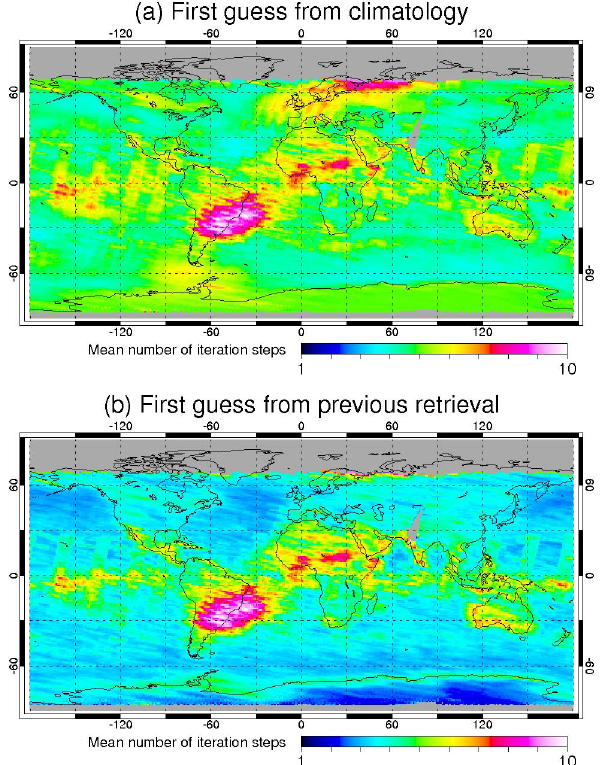
Fig. 7. Influence of first guess on number of iteration steps for February 1998: (a) mean number of iterations when taking the cli- matological profile as starting point; (b) mean number of iterations when the previous retrieval is used as starting